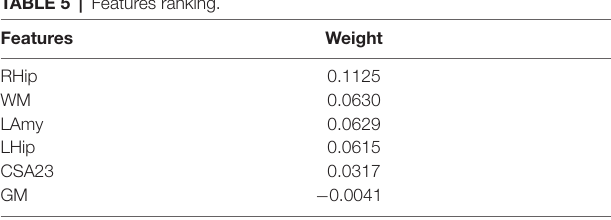
TABLE 5 | Features ranking.